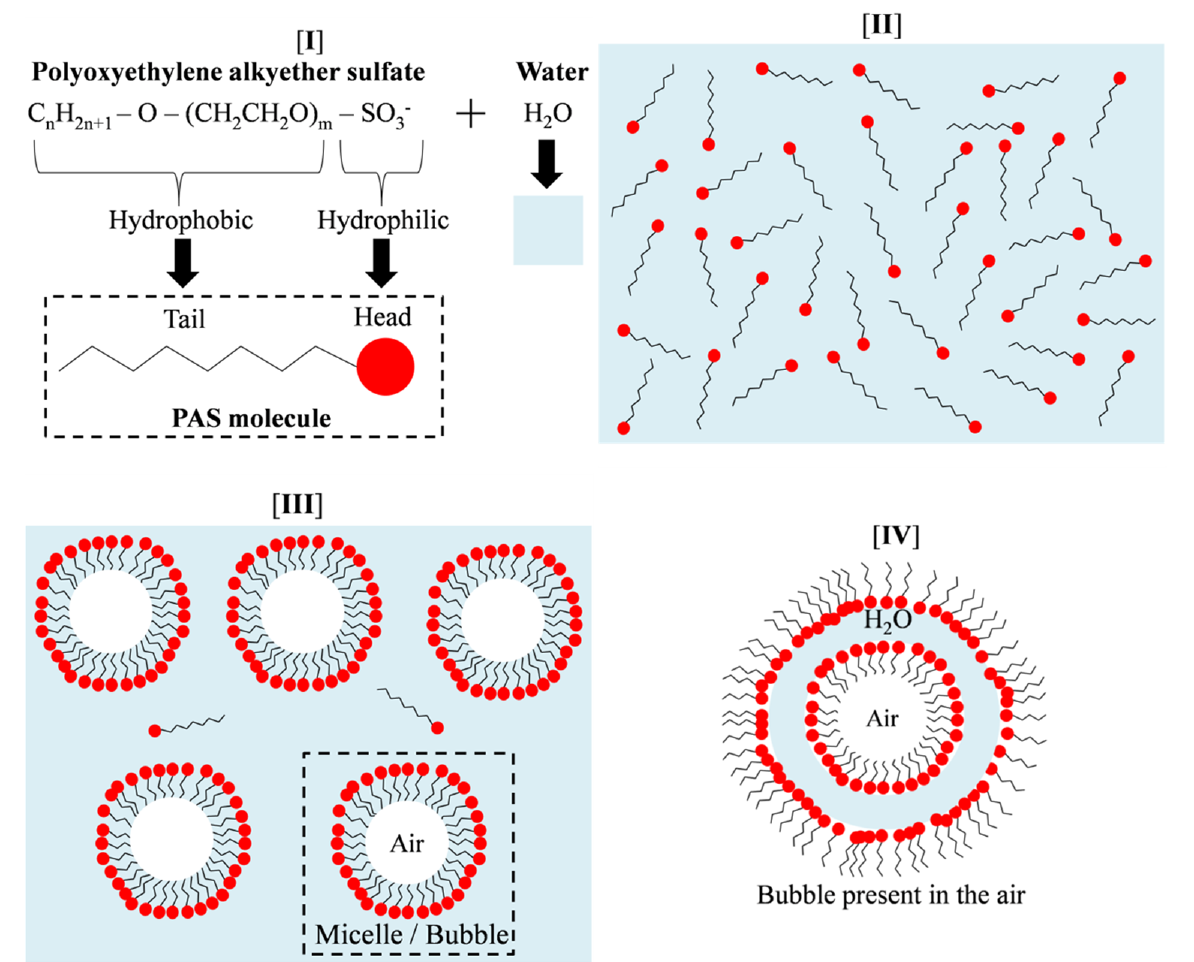
Figure 1. Preparation of PAS foam using a foam generator.